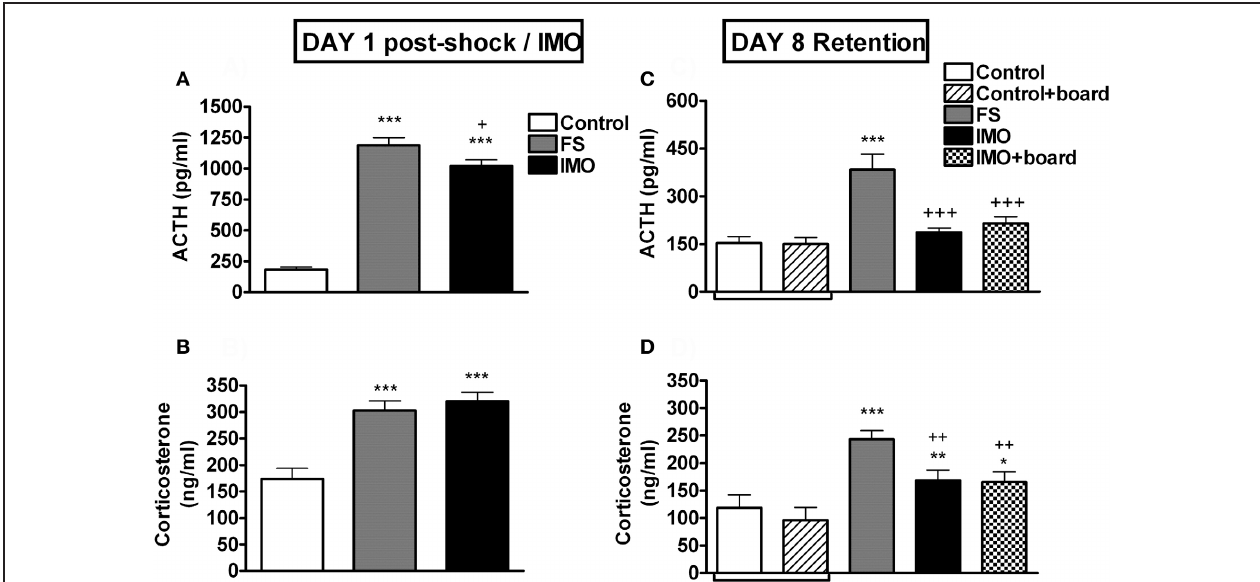
presence of the board or with the board (control-board and IMO-board groups). Control and control + board groups are presented separately in the graphs but they were pooled for the statistical analysis. Panel (A and B) show post-stress hormone levels on day 1. Panel (C and D) show hormone levels on day 8 (retention). ∗ , ∗∗ , ∗∗∗ : p < 0 . 05, p < 0 . 01 and p < 0 . 001 vs. control group; + , ++ , +++ : p < 0 . 05, p < 0 . 01 and p < 0 . 001 vs. FS